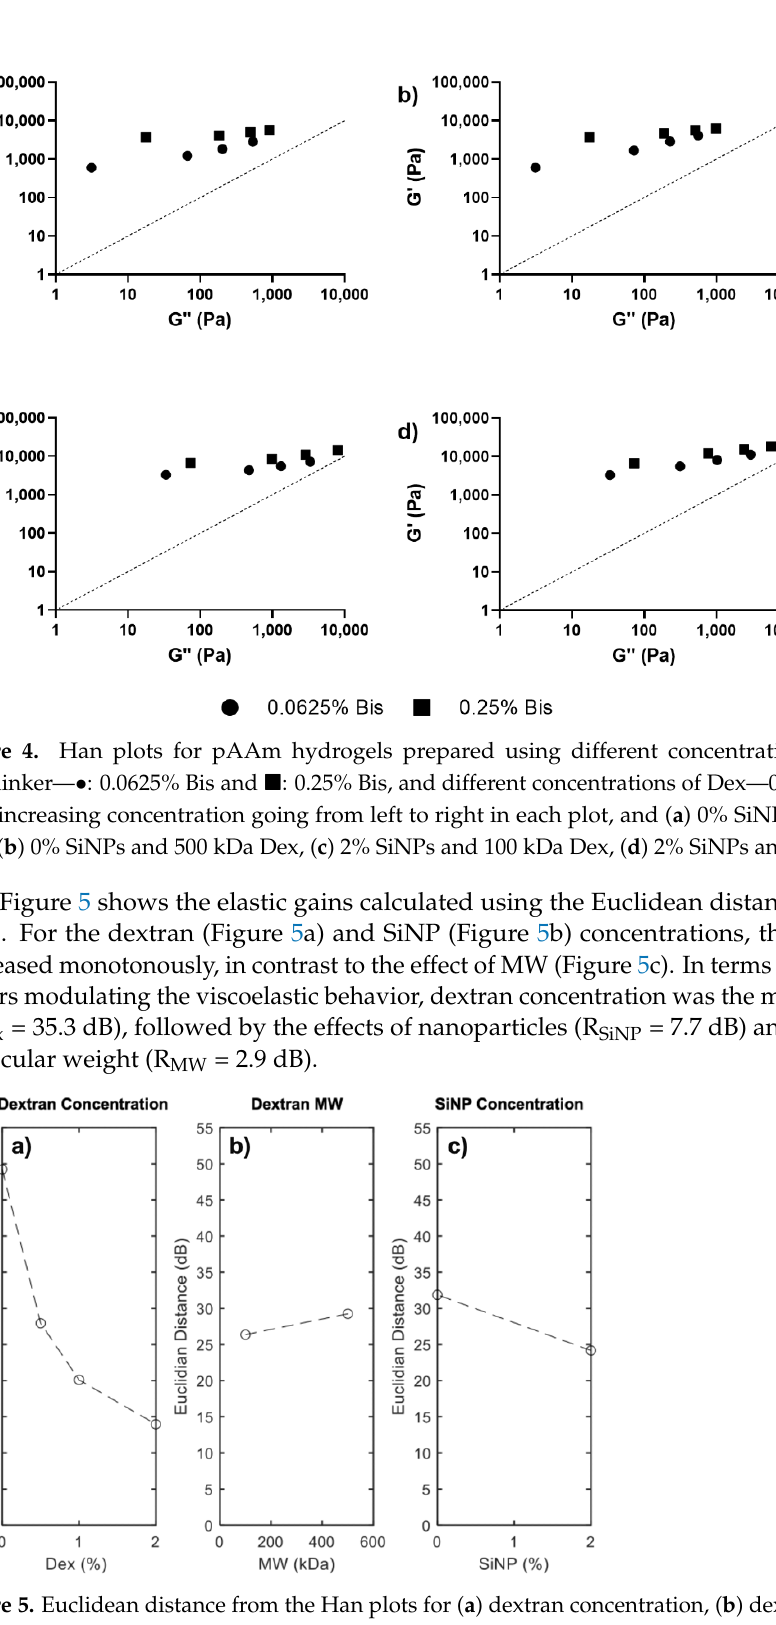
Table 4.  G’ values in units of decibel , computed from transitioning from single to interpenetrating network hydrogel nanocomposites. Bis (%)